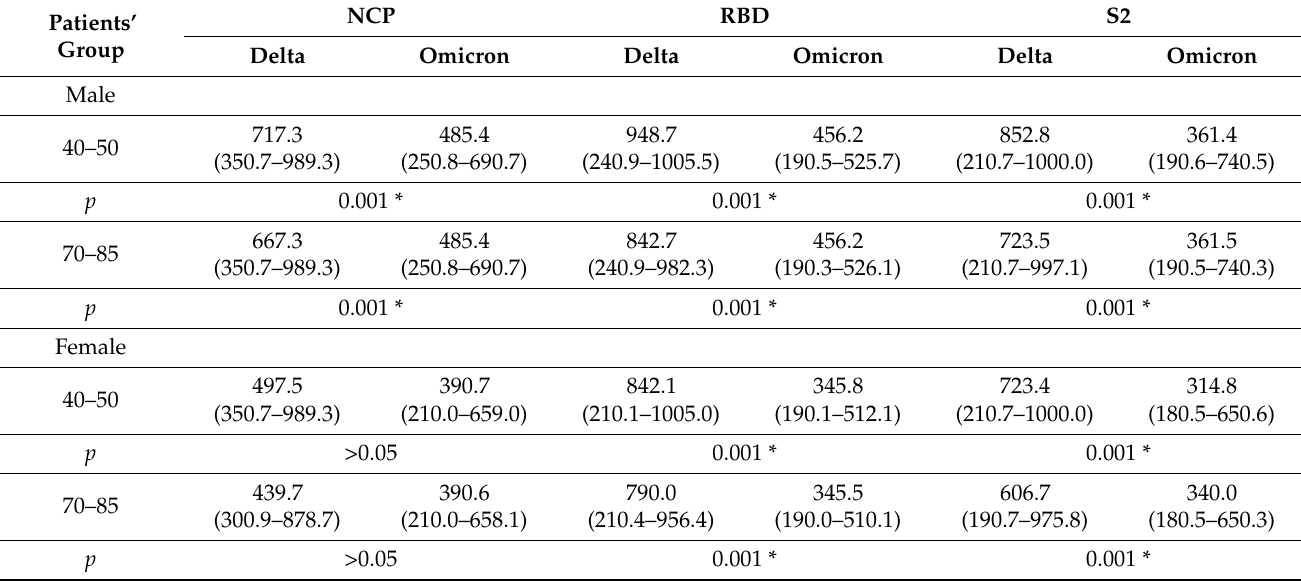
Figure 3. The serum level of NCP, RBD, and S2 antibody in patients after SARS CoV-2 Delta variant and Omicron variant infection by age: ( a ) 40–50, ( b ) 70–85. Among men infected with the Delta variant, statistically, significantly higher levels of all tested antibodies were found in both tested age groups compared to the Omicron variant (Table 3). The level of NCP antibodies in the group of women did not differ depending on the age group. Among women in both studied age groups, the difference in the level of NCP antibodies was not statistically significant depending on the variant of SARS-CoV-2, Delta, or Omicron. However, the level of RBD and S2 antibodies in both age groups was higher in women infected with the Delta variant. This difference was statistically significant. Both in women and men in the younger age group (40–50), a slightly higher level of the tested NCP, RBD, and S2 antibodies was observed in comparison to the older age group (70–85) (Table 3). Table 3. The level of NCP, RBD, and S2 (U/mL) by age, sex, and SARS CoV-2